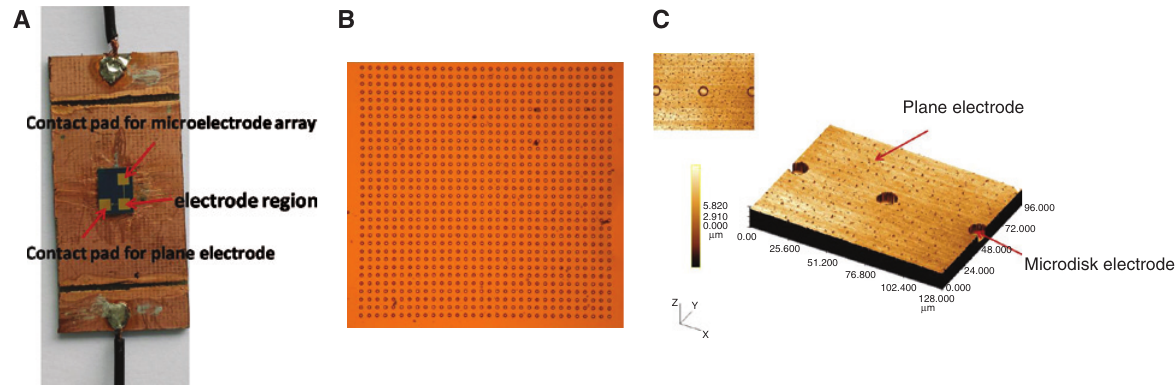
Figure 3: Images for plane-recessed MEAs. (A) Digital photo of real device; (B) optical image for electrode region, the microdisk electrodes are arranged in a square configuration; (C) confocal image of plane-recessed MEAs, the image is only a part of the electrode systems.